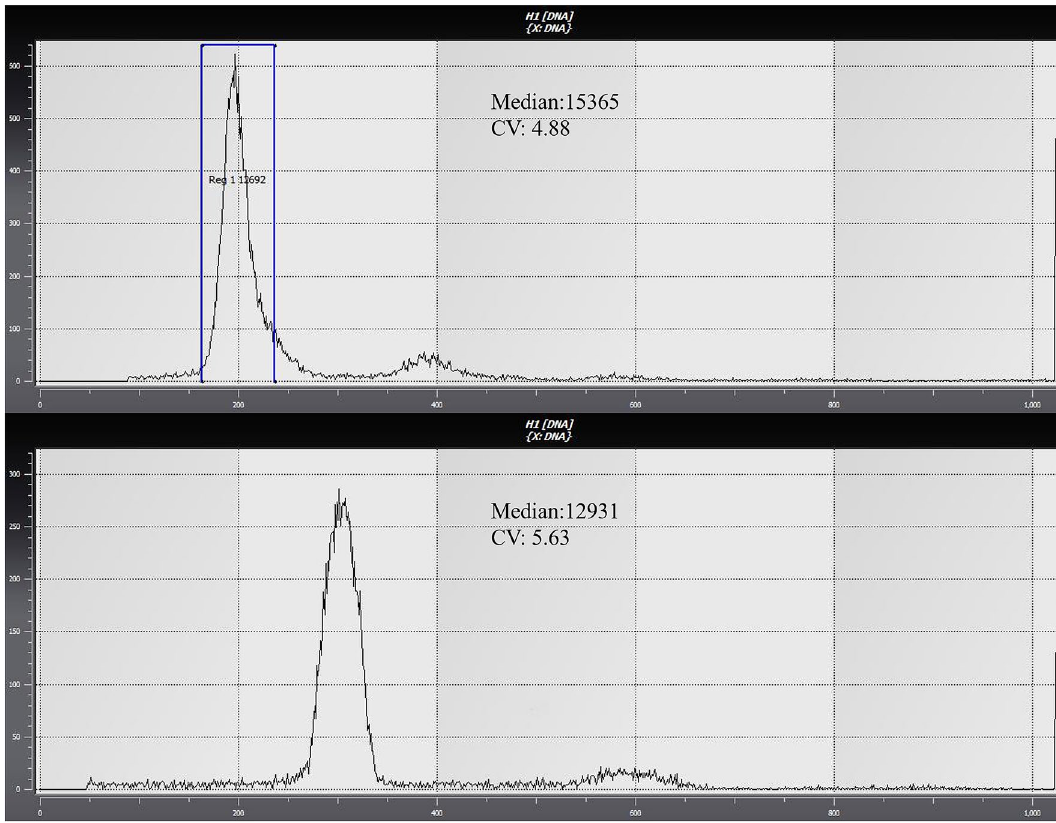
Figure 1. Ploidy test results of diploid sea cucumbers ( A ) and triploid sea cucumbers ( B